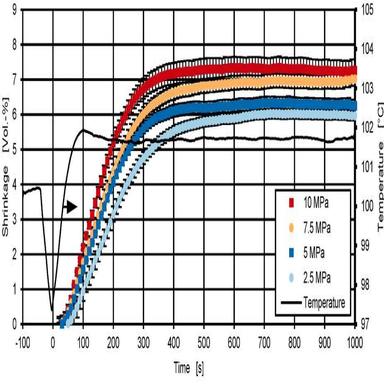
Time dependent shrinkage for different isothermal curing under 100 ◦C and different pressure loads.